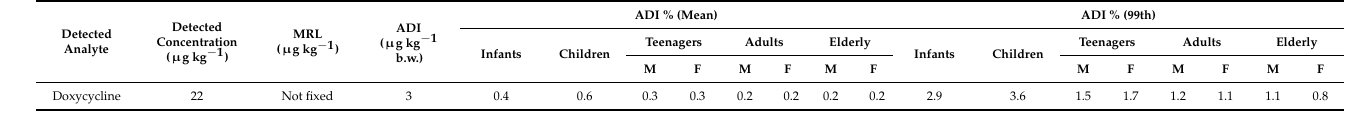
Table 2. Risk exposure based on the Italian